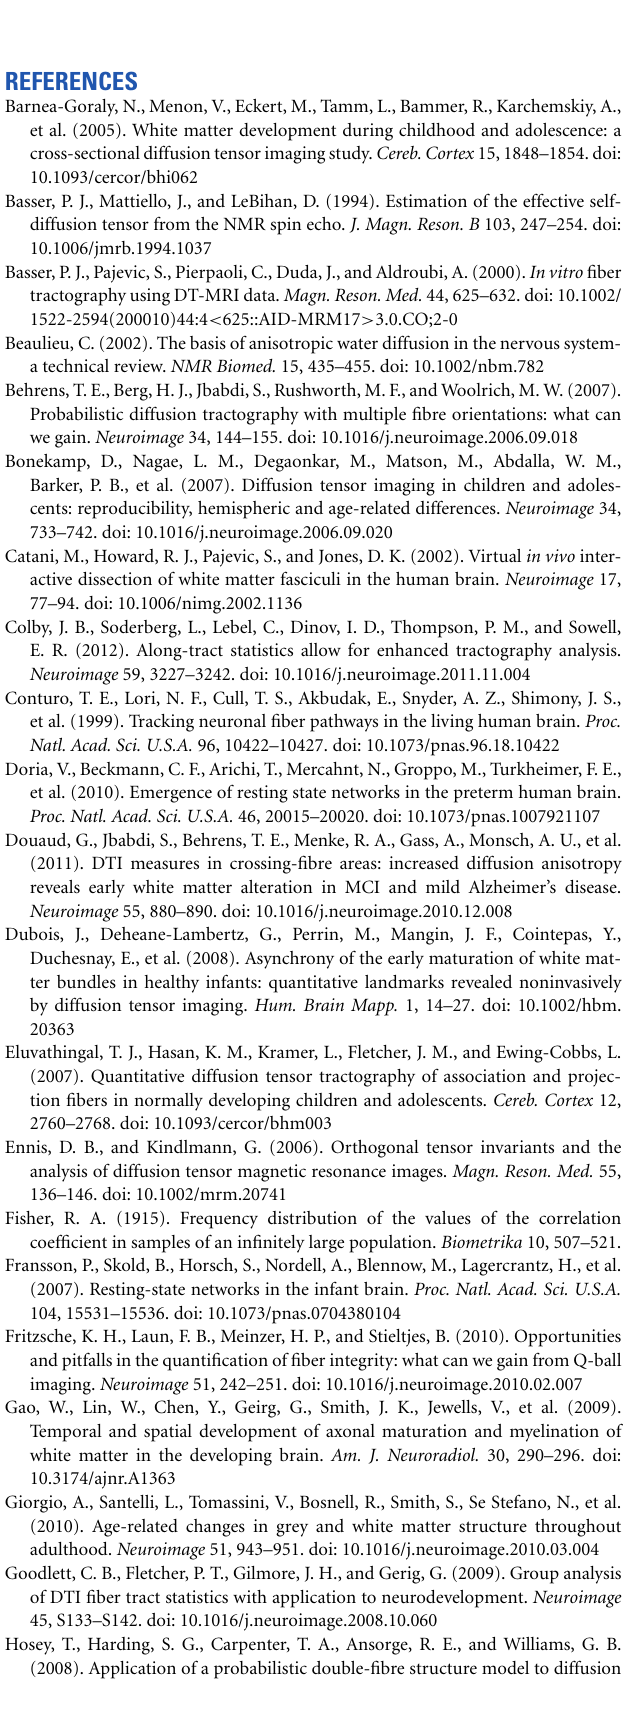
Supplementary Figure 1 | Dendrograms depicting the hierarchical clustering pattern obtained from tract-level FA (A), RD (B), AxD (C) and MD (D) measurements for two subgroups of children around puberty. Dendrograms on the left column are for the subgroup of children younger than 12-years-old (9.5–12 years); those on the right column are for the subgroup of children older than 12-year-old (12–15